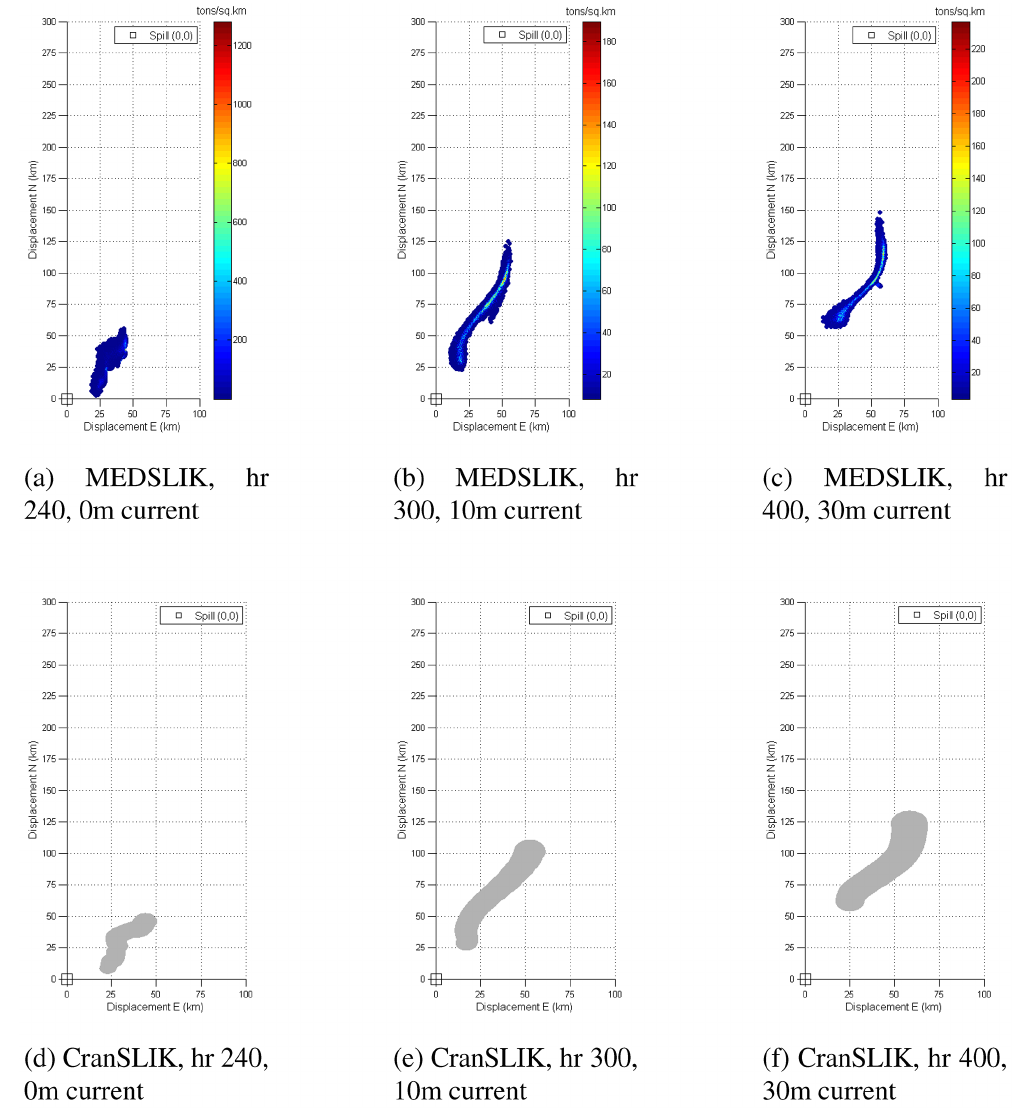
Figure 11. MEDSLIK and CranSLIK “good” ( ≥ 99% oil captured) slick forecasts for the Lebanon case, using the current at different depths as the advective current. Note that CranSLIK does not predict oil